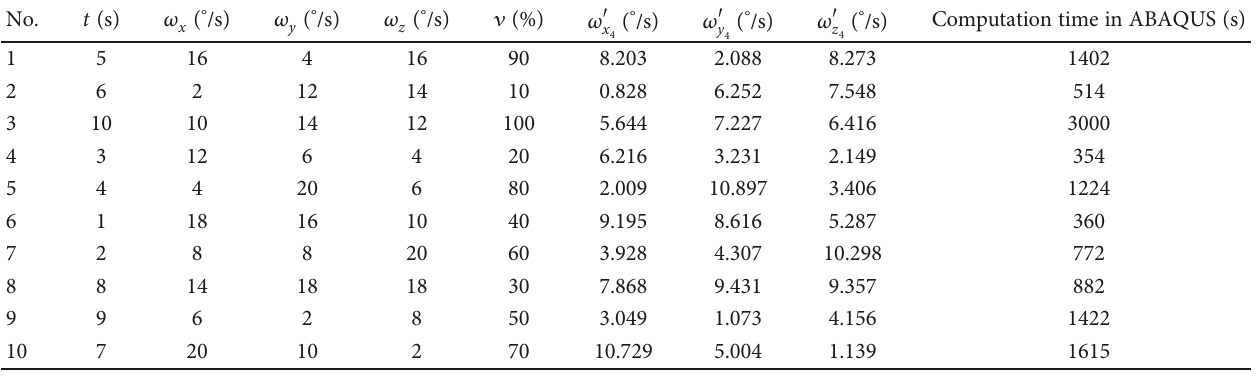
Table 15: Simulation results of liquid storage tank and microsatellite.